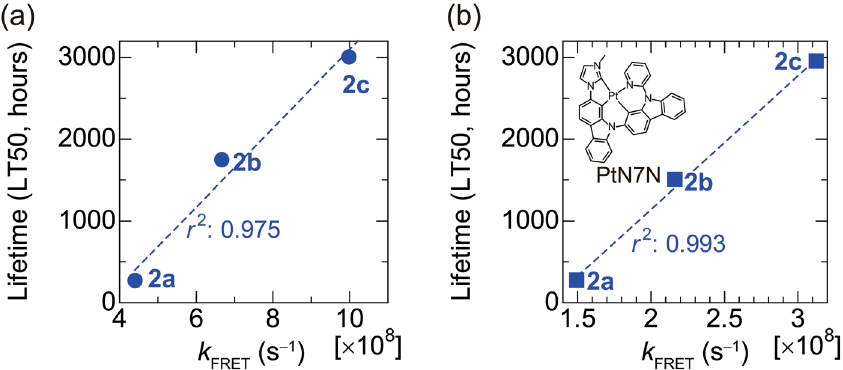
Figure 3. Relationship between Förster transfer rate ( k FRET ) and device lifetime. ( a ) k FRET from host to Ir(mppy) 3 versus host-dependent PHOLED lifetime with TPyQB used as the electron transporting layer. ( b ) k FRET from host to PtN7N versus host-dependent PHOLED